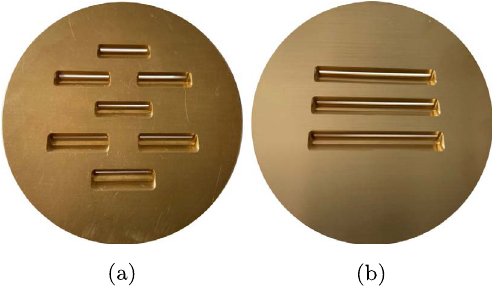
Figure 4. Picture of the samples: a) plate with short slits and b) plate with long slits.